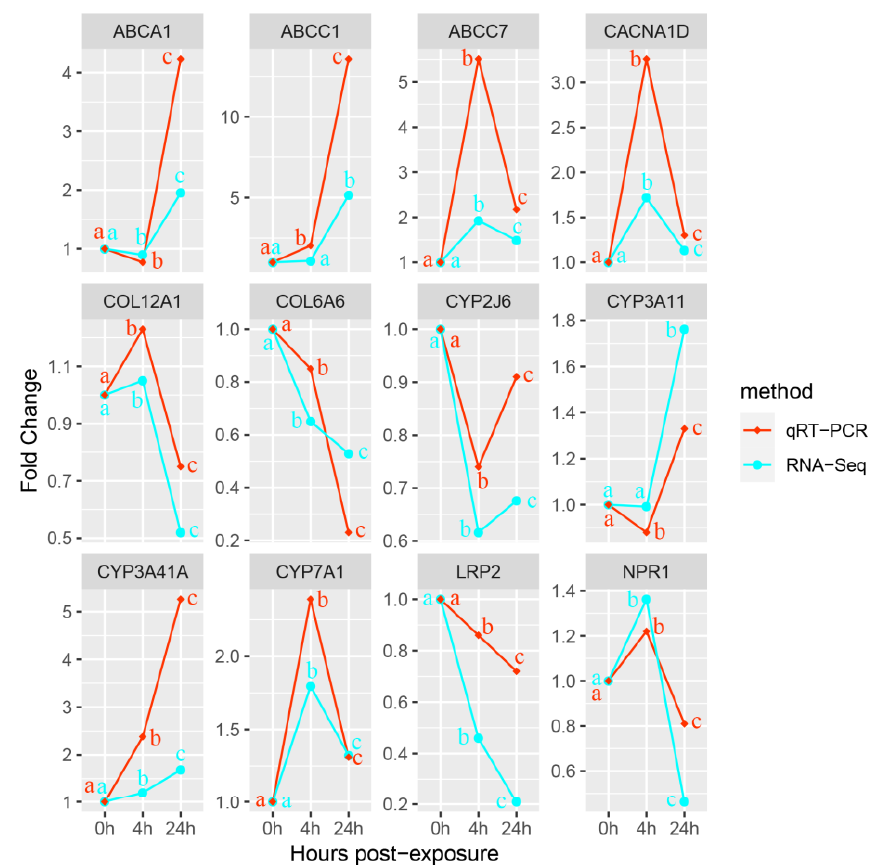
Figure 7. Gene expression verification (qRT-PCR). The abscissa represents Cu exposure time; the ordinate stands for fold change. a, b, and c represent significance of changes in the expression of key genes within 24 h of Cu exposure.